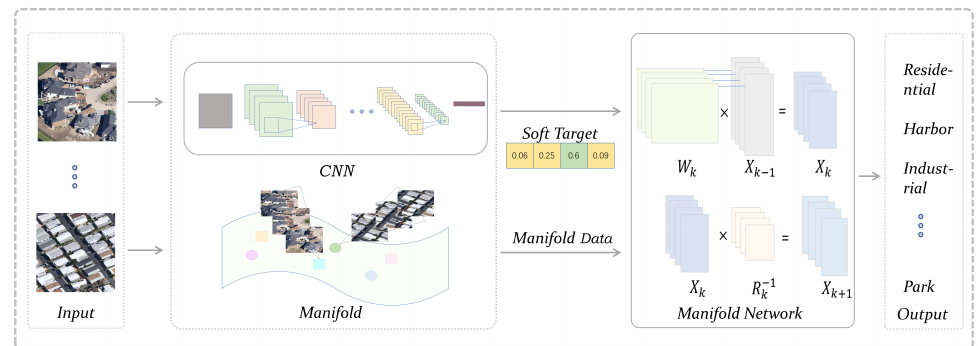
Figure 3. The overview of the proposed method. On the one hand, the images are fed into a convolutional neural network to obtain soft targets. On the other hand, they are also transformed into manifold data. The manifold network is trained with manifold data as input and soft target and hard target as supervised